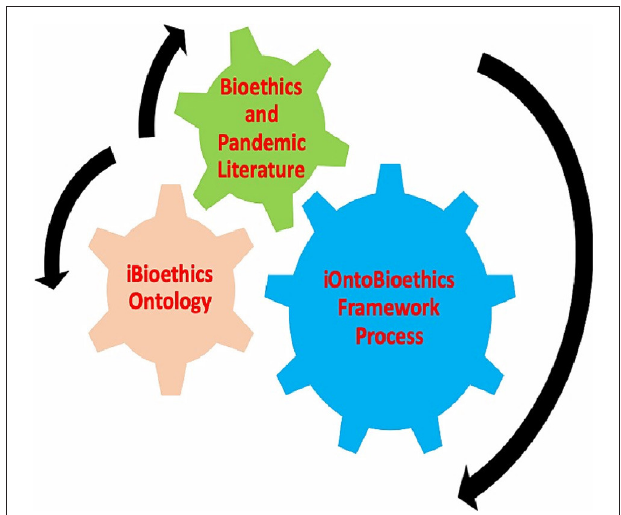
FIGURE 12 | The Novel & Agile iOntoBioethics ontology construction